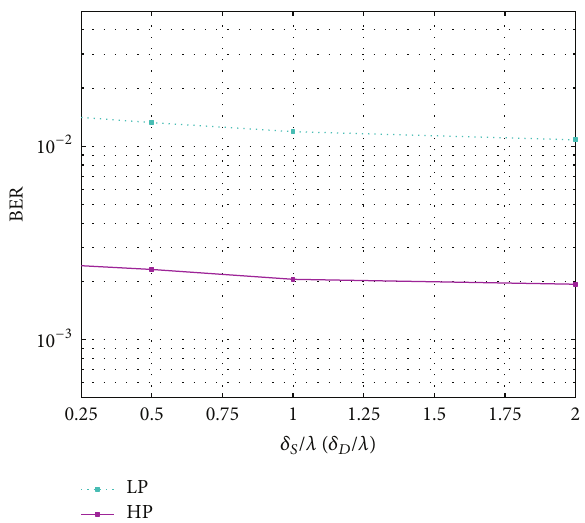
Figure 6: BER for increasing values of antenna inter-element spacing at the source and destination.